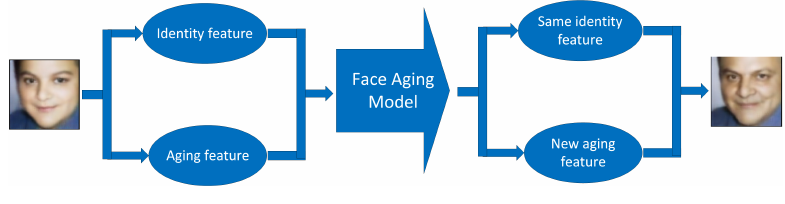
Figure 1. Face aging